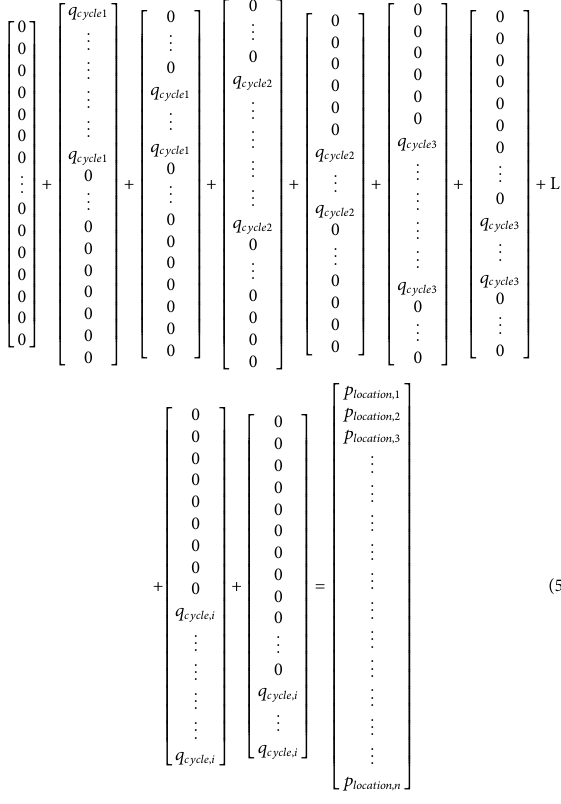
According to the expression in Figure 5, calculate Eq. 5, where, n : represents the number of elements used to represent the length of the wire saw calculated by the model after discretizing the length of the wire saw, q cycle is summed to obtain the workpiece removal volume p location per unit length corresponding to each position on the wire saw. S location indicates the wear of the wire saw at this location. Eq. 6 is obtained from Eq. 3. It shows the relationship between p location and S location in the length direction of the discrete wire